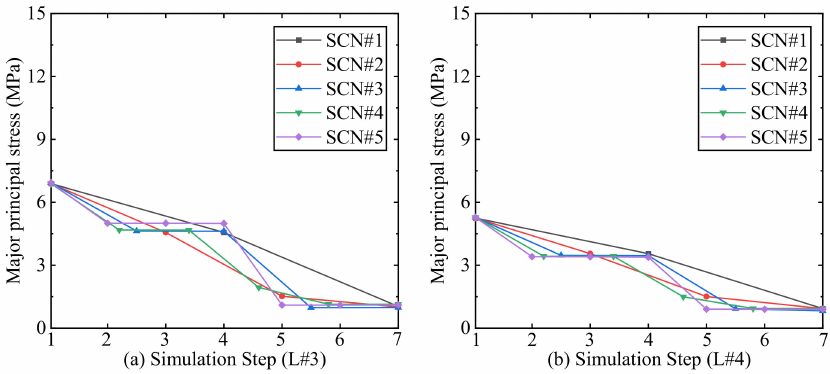
Figure 6. Major principal stress of sidewall middle of level #3 and level